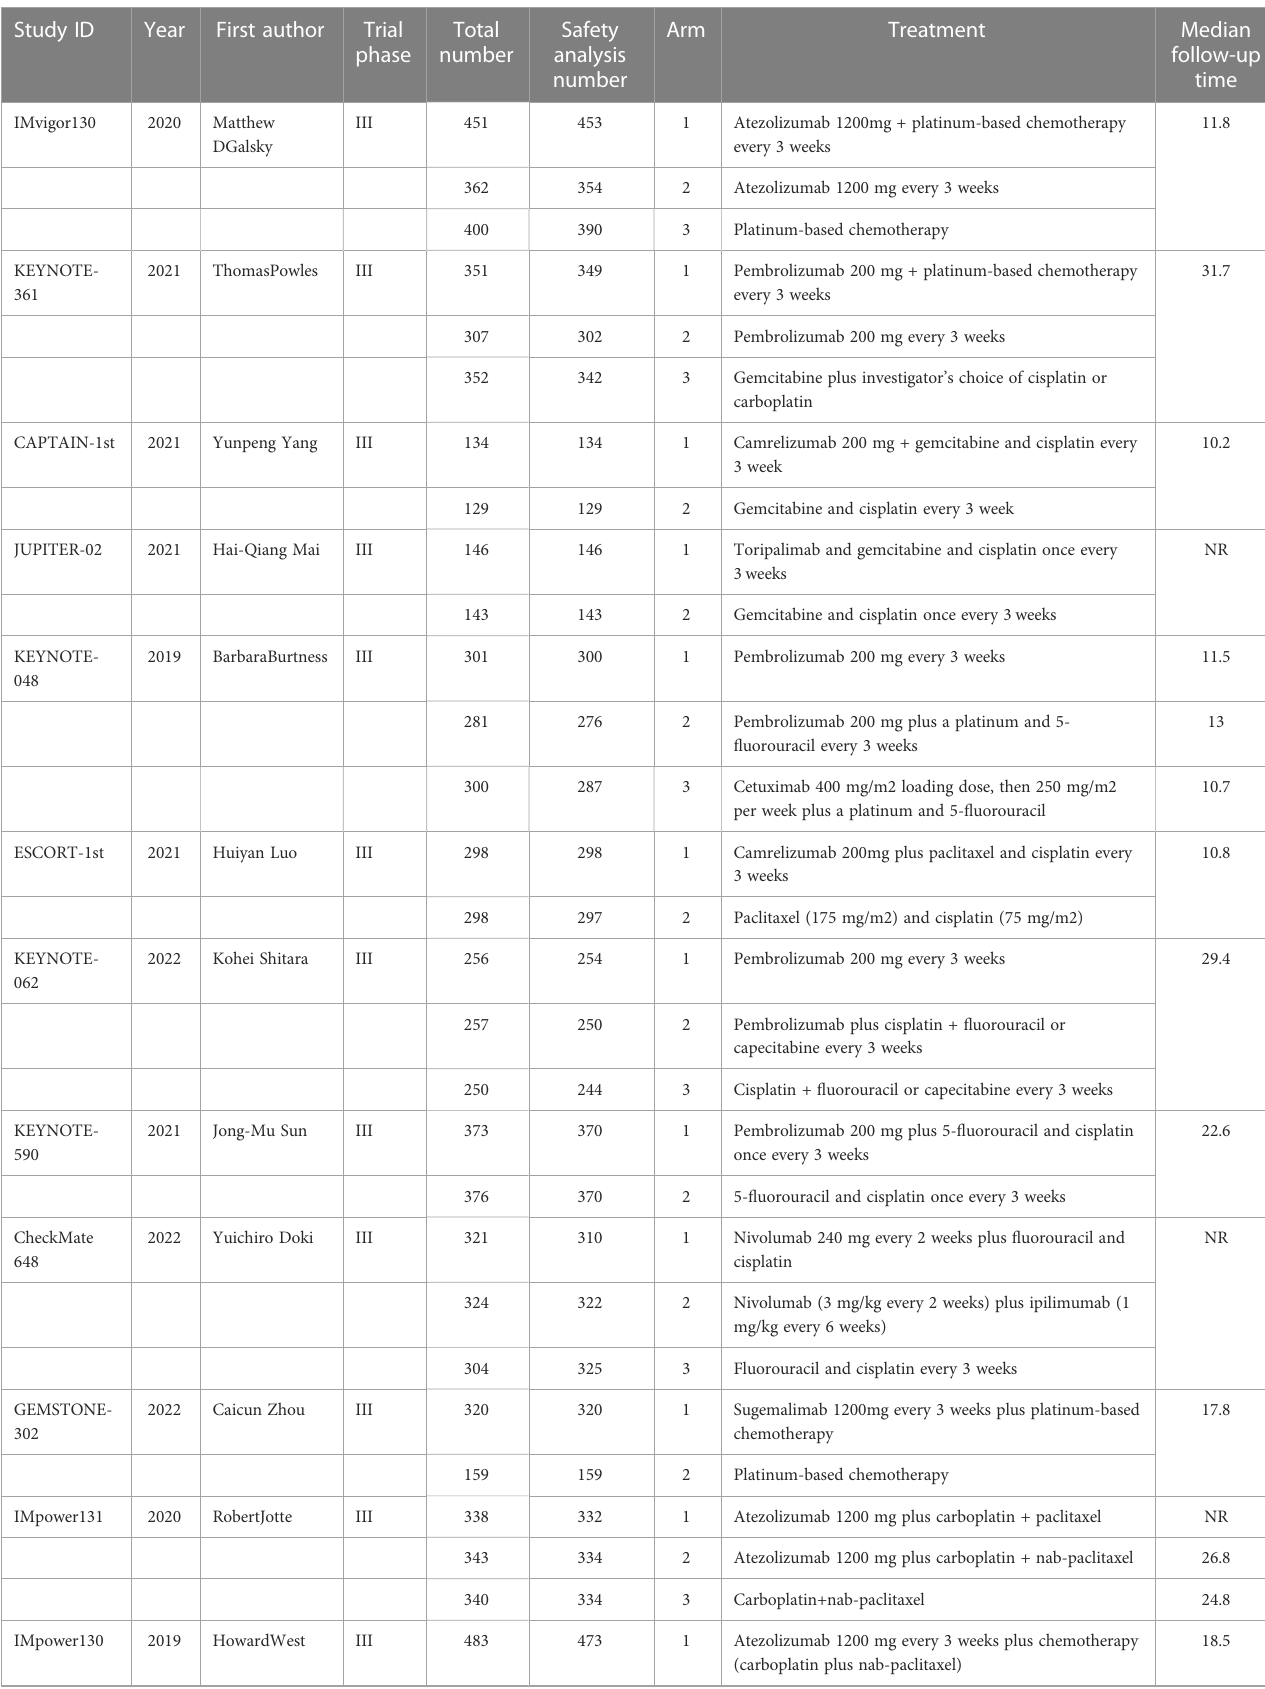
TABLE 1 Baseline characteristics of 33